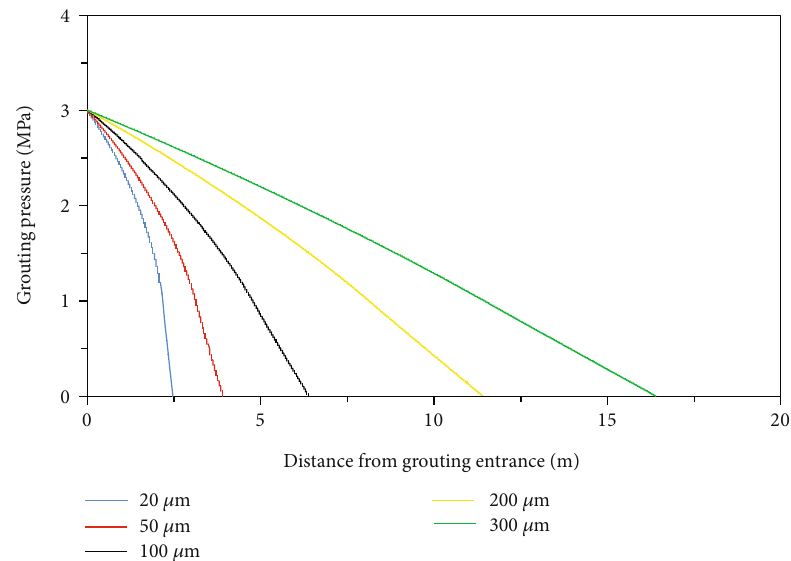
Figure 12: Curve of grouting pressure vs. distance for di ff erent fracture openings.